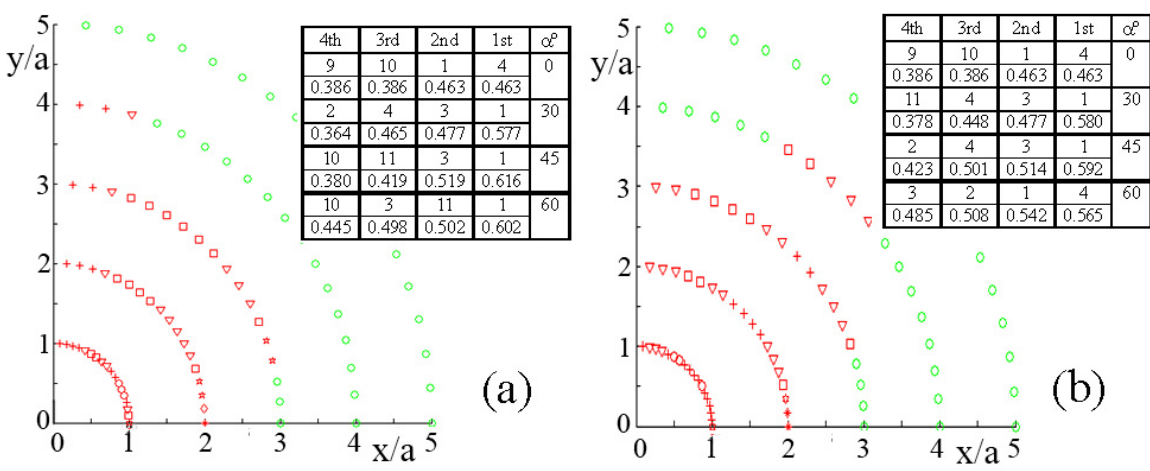
Figure 2. The predicted number of active slip systems in front of a sharp crack tip located at the coordinates’ origin. The crack with length a is located: ( a ) On the plane (cid:3435)30,1,5(cid:3364)(cid:3439) (near (100) and tensile stress along (cid:4670)6(cid:3364),185,1(cid:4671) . ( b ) On the plane (cid:3435)6,5(cid:3364),1(cid:3439) (near (cid:4666)11(cid:3364)0(cid:4667) and tensile stress along (cid:4670)30(cid:3364)(cid:3364)(cid:3364)(cid:3364),37(cid:3364)(cid:3364)(cid:3364)(cid:3364),5(cid:4671) . The symbol “o” indicates single slip, + indicates expected two operative slip systems, a triangle indicates three systems, a square indicates four systems, etc. The tables at the right are the ordered resolved shear stresses on the four most highly stressed slip systems at a constant radial distance a from the crack tip, calculated by Equation (1). The resolved stresses are written as multi- ples of 𝜎 (cid:2998) that is the far field tensile stress applied normal to the crack plane. An active slip system is defined as having a resolved shear stress greater than 0.4 𝜎 (cid:2998) . 3. Results The FCGR in polycrystalline nickel specimens is shown in Figure 3. The FCGR of the slowest growing crack ( E ) is plotted in Figure 4 along with the FCGR in the tested mono- crystals. All the monocrystal specimens exhibit a lower ( ∆ K I ) th relative to the polycrystal- line specimens. This observed lower threshold for crack propagation may be attributed to the reduced resistance to crack growth in the absence of grain boundaries. Another reason may be that the FCGR in monocrystals is intrinsically higher. If this is the real behavior, then the fatigue crack growth curves are expected to be shifted upward and their thresh- olds are concurrently shifted to the left, i.e., to lower values of ∆ K I [21]. This observation may hint at the expected similarity between long cracks in a monocrystal and short cracks in polycrystals. Furthermore, a difference in FCGR is observed for different crystallo- graphic orientations of the crack plane, despite the fact that the FCGR was not the same in repeated tests of specimens with the same crystallographic orientation ((100) crack plane). Notably, the Paris law region of the FCGR curves for the polycrystalline specimens is sim- ilar in nature to that for the single-crystal specimens. Our fatigue machine enables work- ing in load control mode only when the crack length is relatively short. When the crack length becomes longer, the capability of the machine to keep the selected load lags behind the increasing displacements . The momentary stress intensity factor was calculated using the instantaneous load. As the crack length increases, the applied Δ σ decreases, resulting in a moderate increase of d a /d N . This moderate change in d a /d N was therefore, we believe that in pure constant load conditions the obtained trends will be similar.